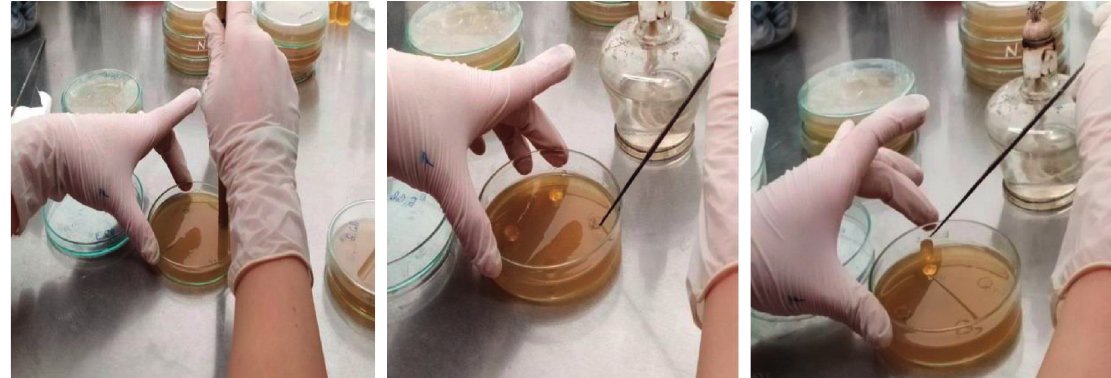
Figure 15: Steps to drill jelly wells.